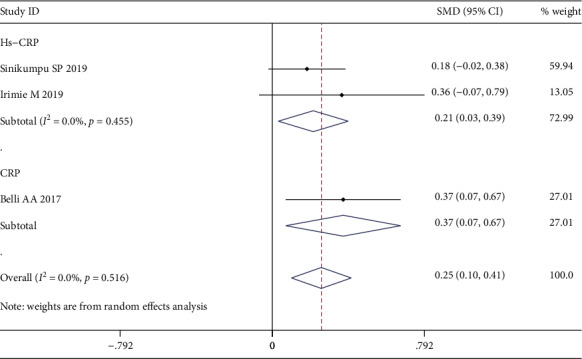
Forest plot of the association between rosacea and C-reactive protein (CRP) in case-control studies.